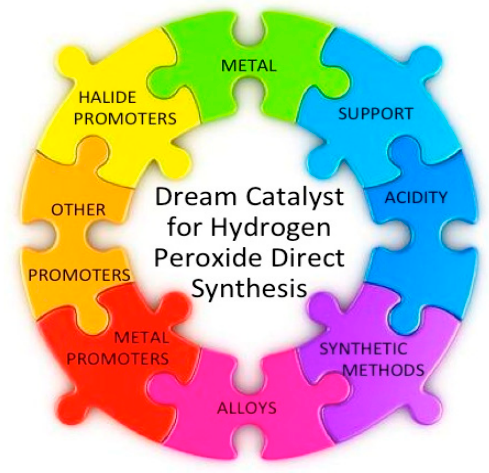
Figure 2. The convergence of the different features necessary to define the “dream catalyst”.